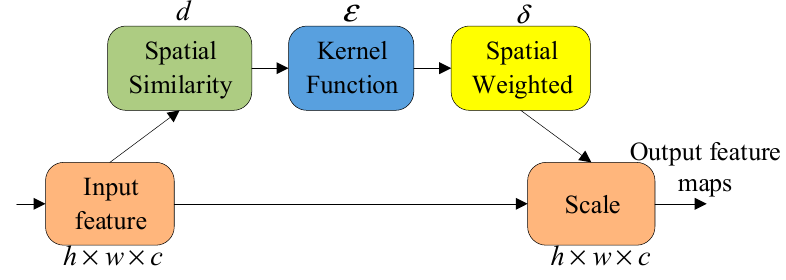
Figure 1. The structure of the spatial weighted attention network. d , the greater the difference between the neighborhood pix- The larger the value of i x and center pixel x inside the pixel block. In this case, the feature contribution of els i j x should be smaller when judging the category of the center pixel. j